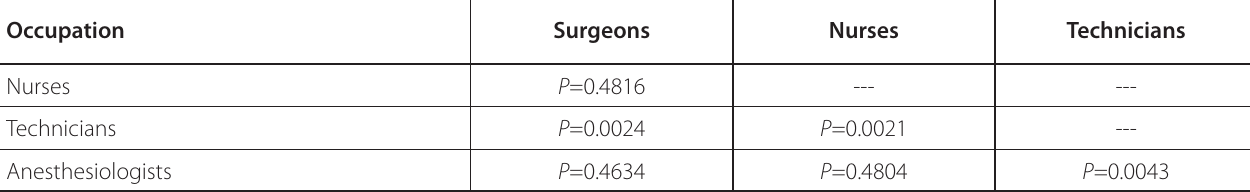
Table 4 . Frequency of disruptions according to the occupation of participants* (n = 43).